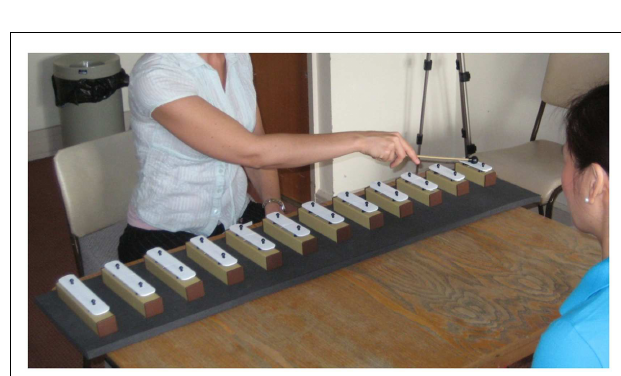
FIGURE 3 | During the intervention session, the patients observed and repeated the experimenter modeling simple scales and melodies . A series of three foam frames allowed the spacing between chime bars to be increased as performance improved (see text for more